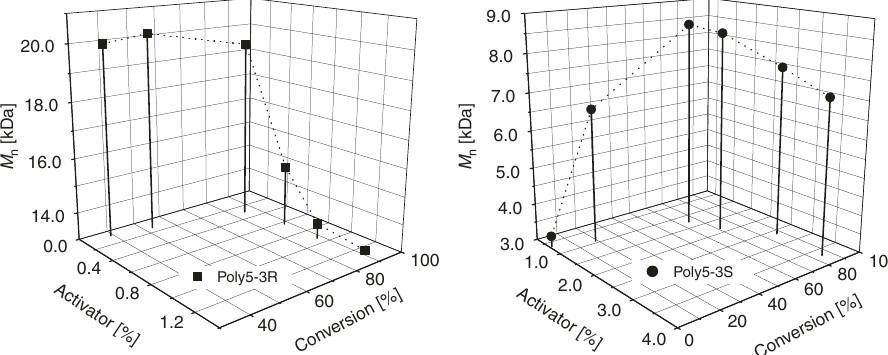
Fig. 6 Effects of the amount of activator. In fl uence of the activator concentration on the conversion and M n of poly5-3R and poly5-3S (Supplementary Figs. 11 – 14, Supplementary Table 13). Conditions: 3.0 mmol 5-3S or 5-3R , 3.0 mol% NaH on paraf fi n, 190 °C, 1